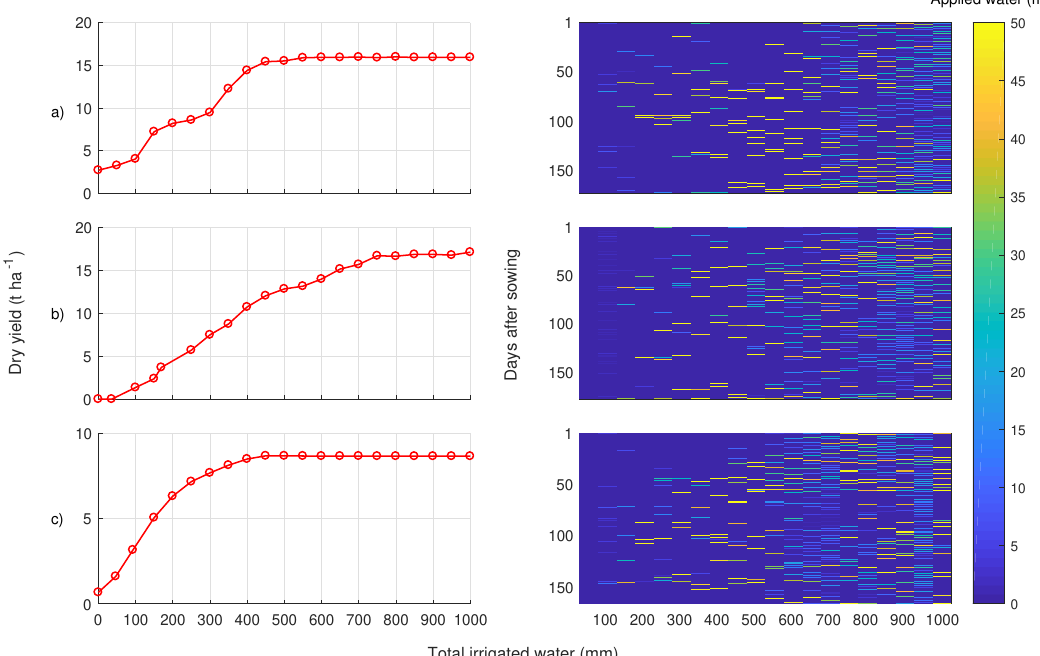
Figure 2. Water-yield functions ( left side ) and optimal irrigation schedules ( right side ) for maize ( a ), sugar beet ( b ), and wheat ( c ) under clay loam soil